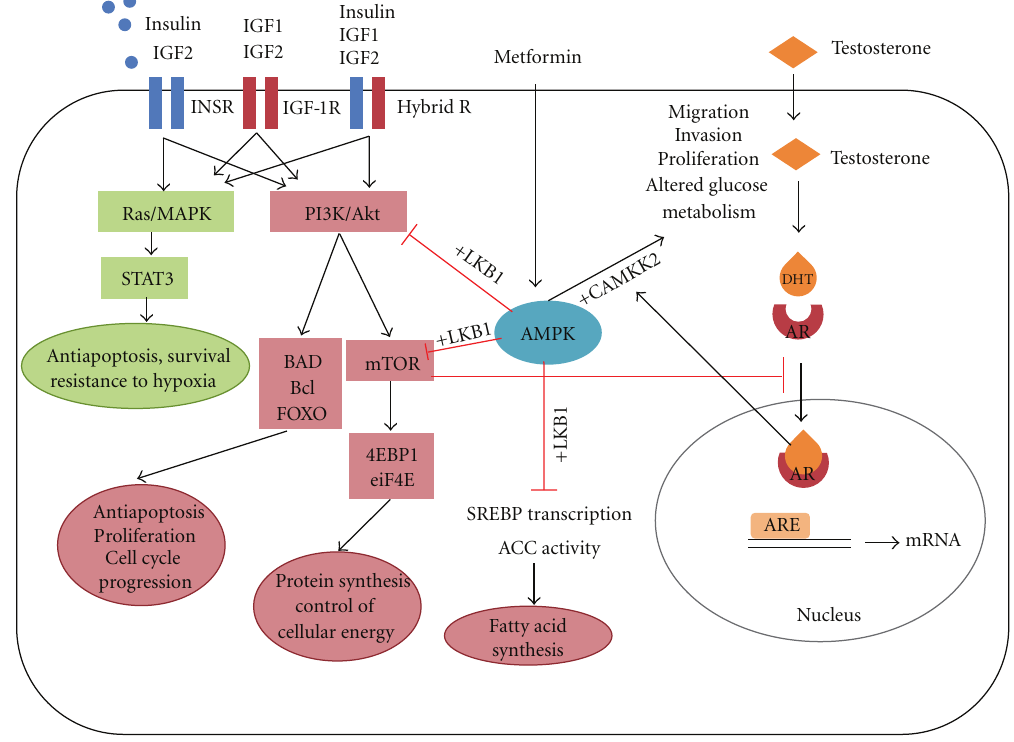
Figure 1: Insulin receptor (INSR) belongs to a family of receptor tyrosine kinases that includes the receptor for insulin-like growth factor 1 (IGF-1R). Many tumour types have upregulated expression of IGF-1R, INSR, and potentially hybrid INSR/IGF-1Rs which facilitate increased activation of mitogenic, prosurvival and protein synthesis pathways following activation by of ligands insulin, IGF-1 or IGF-2. IGF-1 can bind the INSR with 2.5% the e ffi ciency of insulin. Insulin, at physiological levels, will not activate the IGF-1R. Insulin and IGF-1 can activate signalling with varying potency through the hybrid INSR/IGF-1R. IGF2 is able to signal through each of the INSR, IGF-1R, and hybrid receptor (Hybrid R). Ligand binding to the INSR and IGF-1R activate numerous downstream pathways including phosphatidylinositol 3 kinase (PI3K)/Akt and Ras/MAPK pathways with many well-characterised downstream e ff ects including increased glucose metabolism, inhibition of apoptosis (e.g., via FOXO and BAD-mediated pathways), and stimulation of cell proliferation (e.g., via mammalian target of rapamycin; mTOR). Reciprocal feedback regulation occurs in prostate cancer cells between the AR signalling and signalling through the PI3K-AKT-mTOR pathway. Unfettered activity through this pathway, associated with the common PTEN mutation, inhibits AR signalling and suggests a possible pathway to androgen-independent growth of prostate tumours. AMP-activated protein kinase (AMPK) is a potentially bifunctional modulator in prostate cancer cells. Activation of AMPK modulates insulin signalling by negatively regulating mTOR control of protein synthesis and halting cell proliferation. AMPK activation also promotes fatty acid oxidation and downregulates expression of SREBP and activity of acetyl-CoA carboxylase (ACC) resulting in decreased fatty acid synthesis. However, AMPK has complex regulation in prostate cancer cells and may potentiate increased proliferation and migration when activated downstream of the AR under the control of AR responsive regulator calcium/calmodulin-dependent protein kinase kinase 2 (CAMKK2). AR directly regulates CAMKK2 and upregulates AMPK which mediates AR-induced migration and invasion in a CAMKK2-dependent manner. In studies where metformin activation of AMPK results in cessation of cancer cell growth, signalling is thought to be through LKB-1 tumour suppressor; therefore, competition for AMPK signalling via LKB1 stimulation versus AR-mediated CAMKK2 activation could result in altered functional outcomes. DHT, dihydrogen testosterone; AR, androgen receptor; ARE, androgen response element; MAPK, mitogen-activated protein